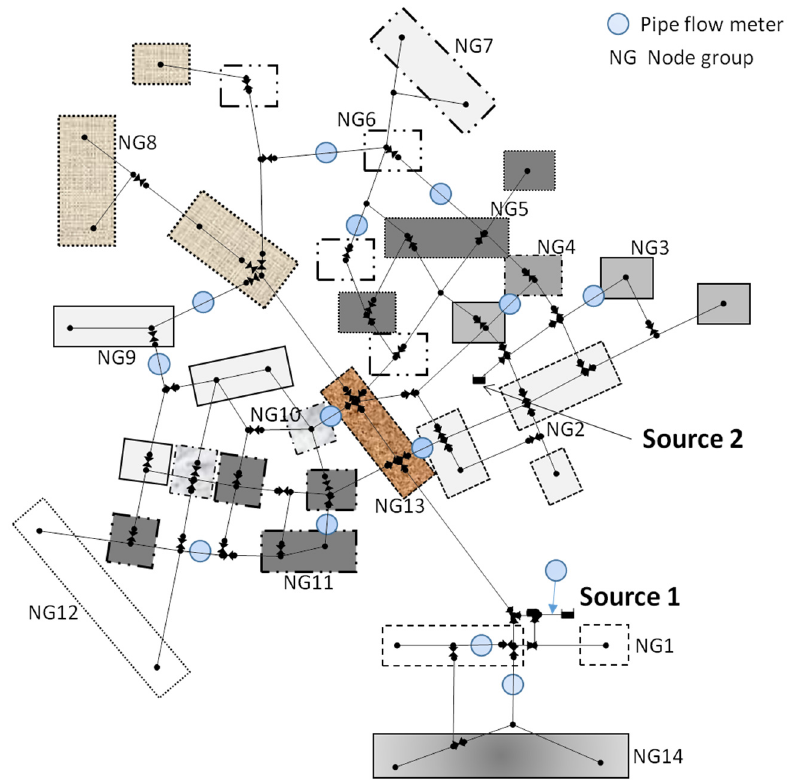
Figure 9. Optimal node groups identified by the proposed model. A node that is not grouped (boxed) has no external demand. Therefore, demand estimation is not required.